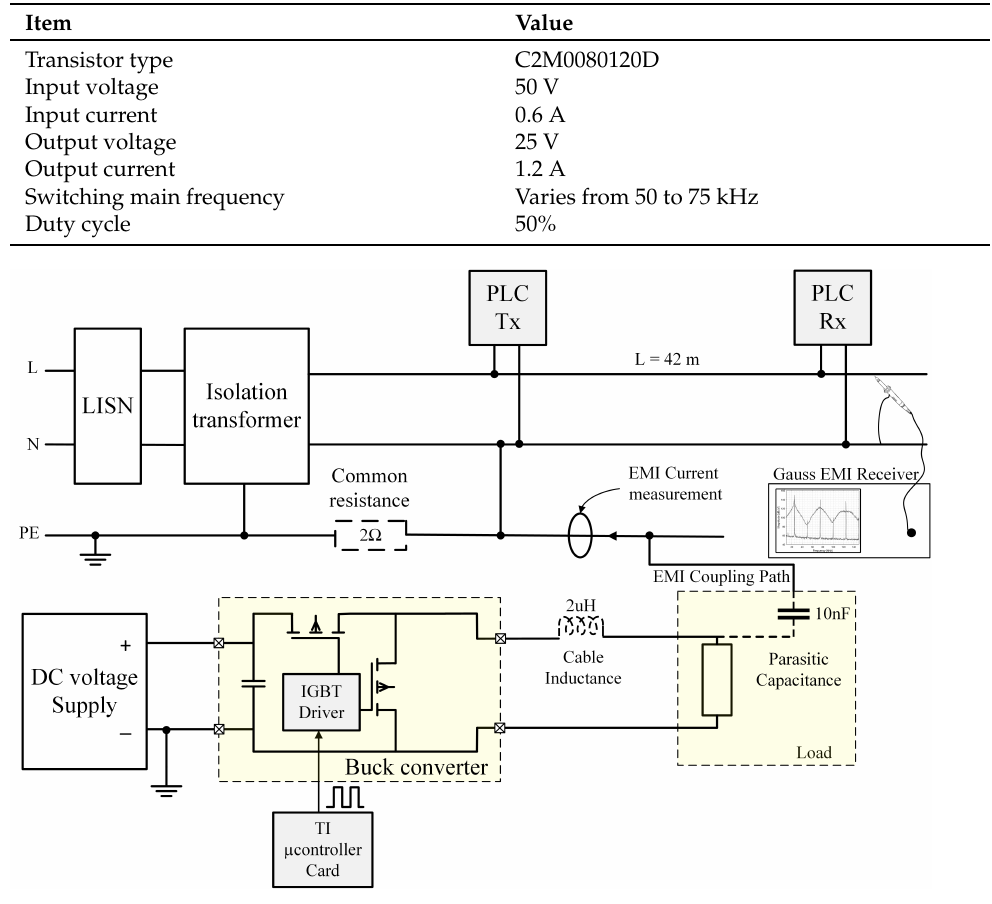
Figure 3. Connection diagram of the system.